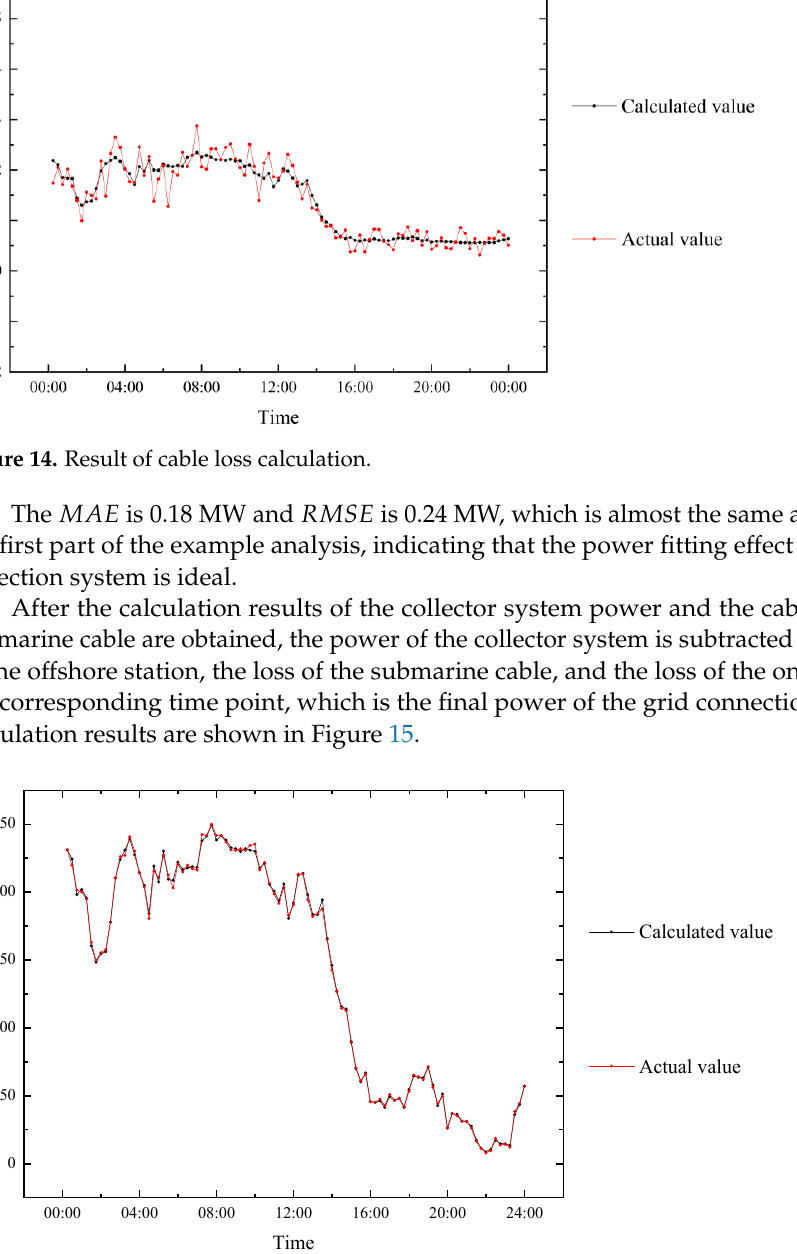
Figure 15. Step-by-step mapping of grid connection point power calculation results.